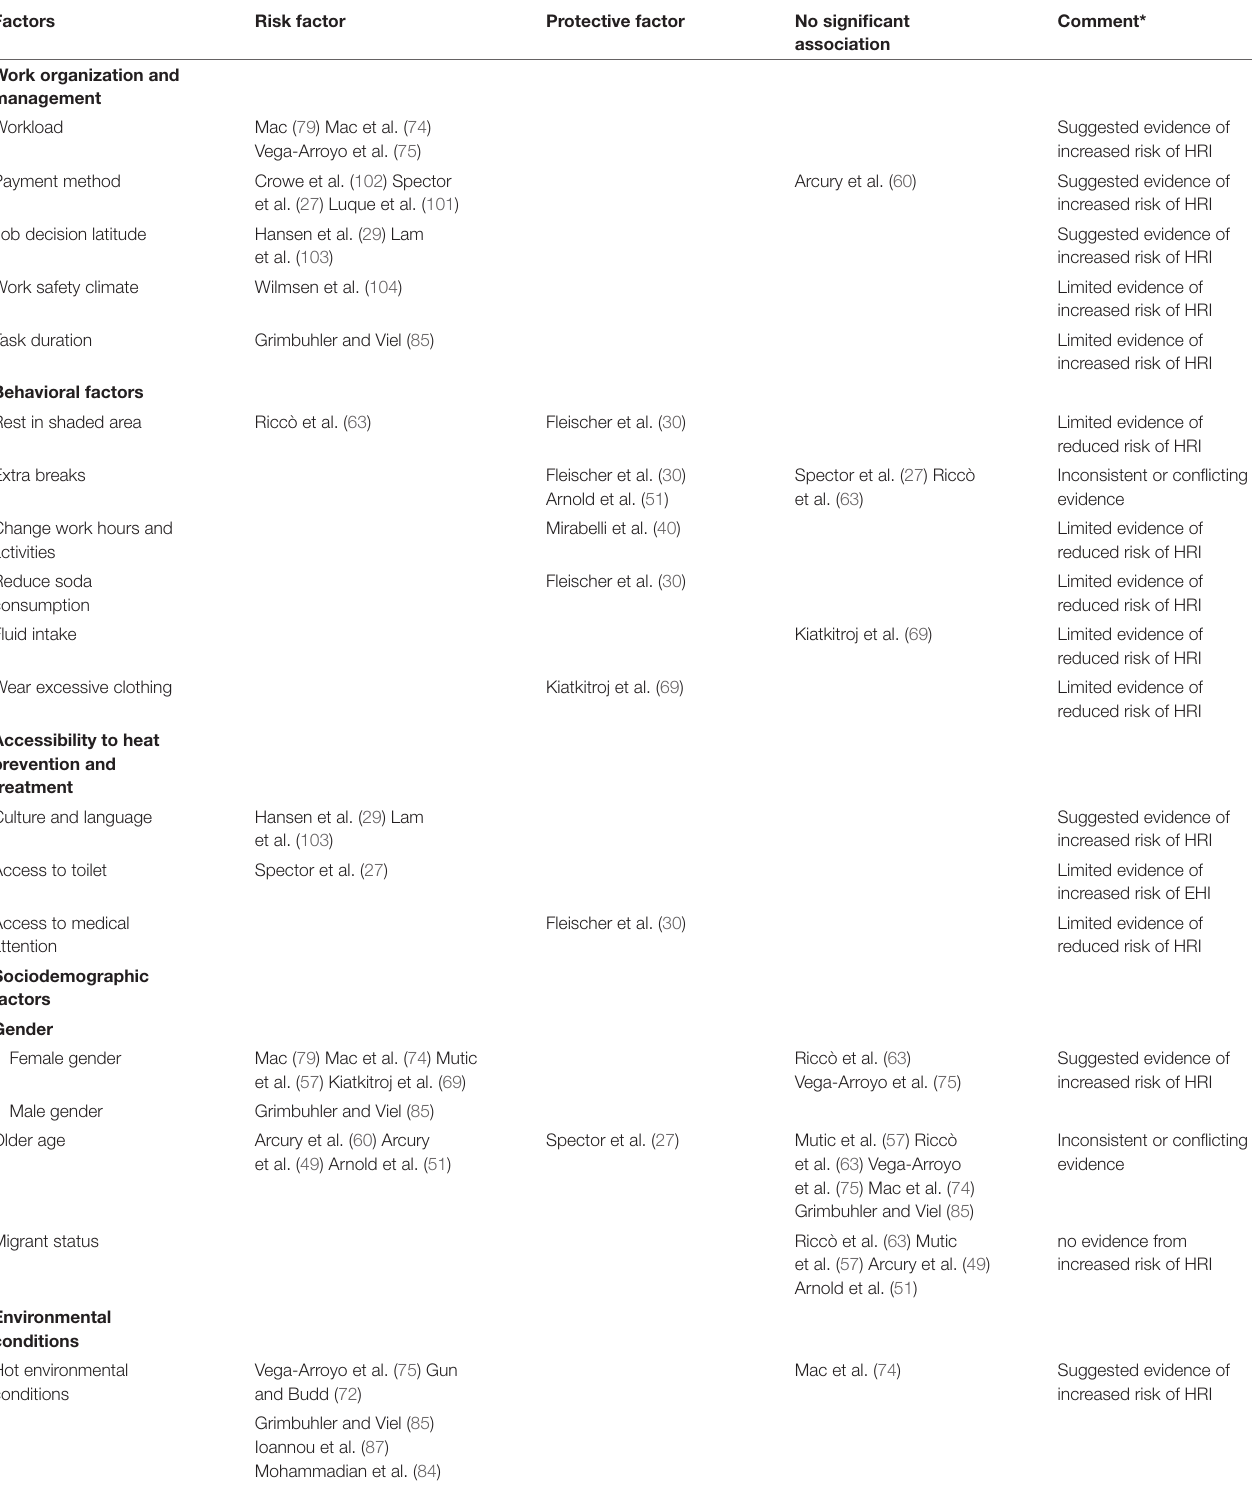
TABLE 3 | Risk and protective factors associated with